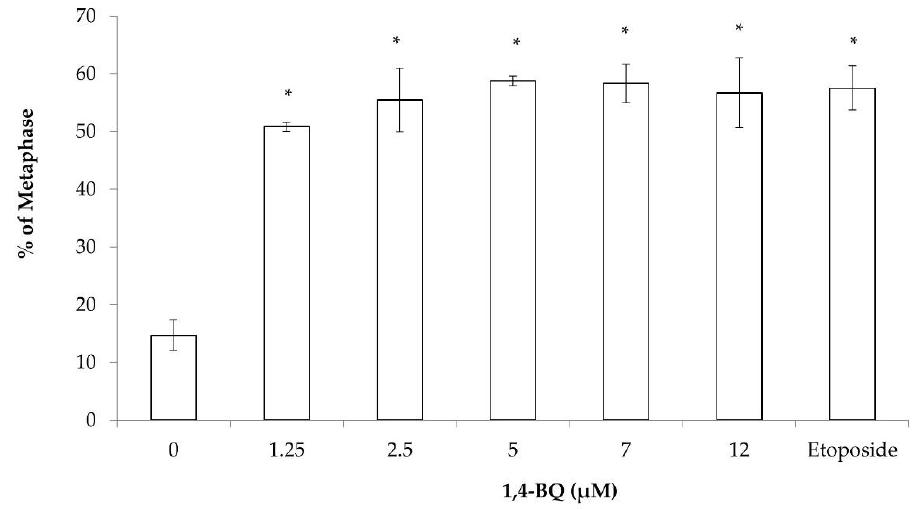
Figure 9. CA of erythroid progenitor cells harvested after 7 days of CFU assay following pre-exposure of MBMCs to 1,4-BQ for 24 h. Twenty metaphases were scored for each experimental group and the percentage of CA is as presented. Data are presented as the mean ± S.E.M. ( n = 3) and analyzed by using one-way ANOVA. * p < 0.05 compared with the negative control group.